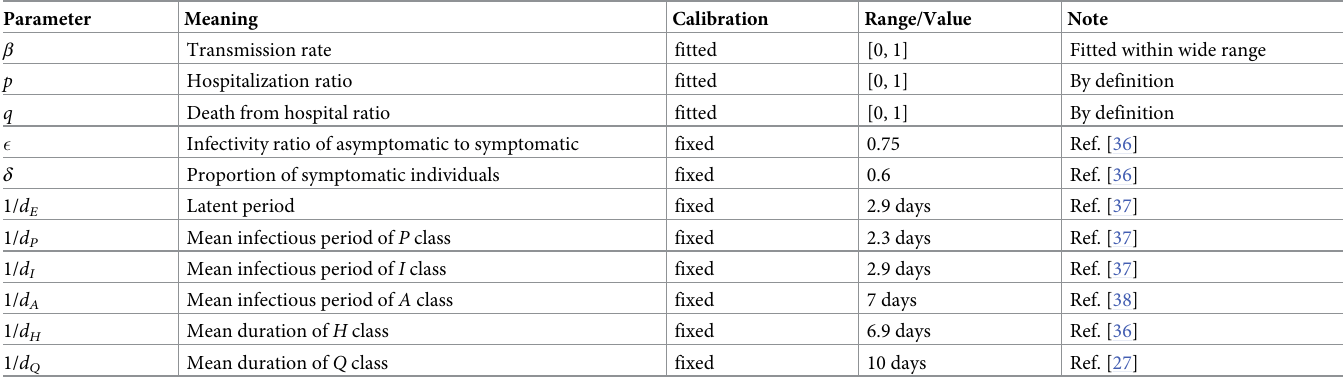
Table 2. Parameters for the model in Fig